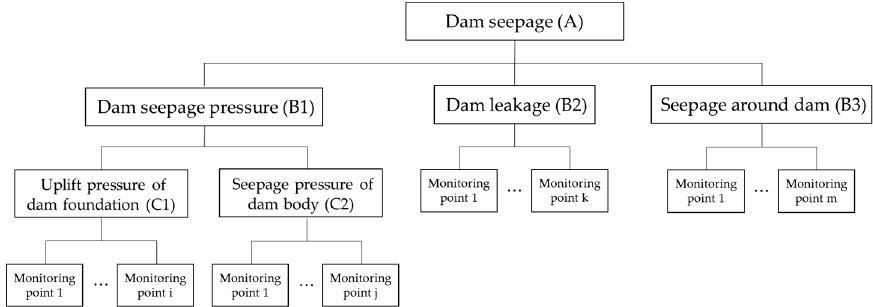
Figure 1. Comprehensive evaluation indicator system of concrete dam seepage.